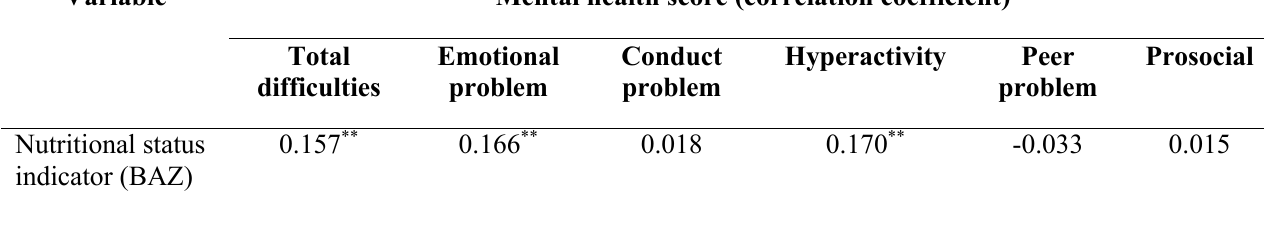
Table 6 . Comparison of mental health score by nutritional status indicator